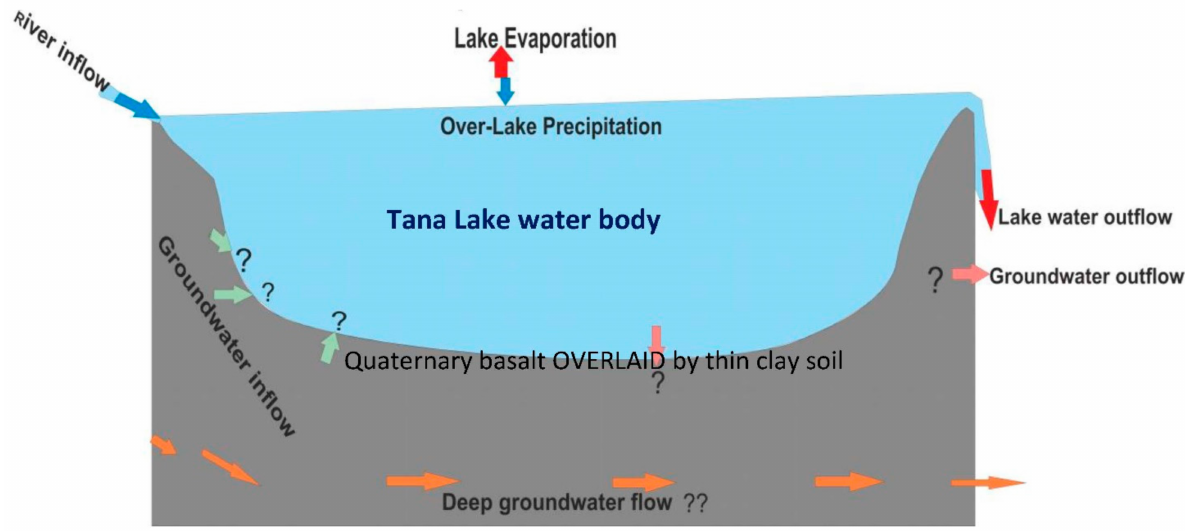
Figure 4. Conceptual diagram depicting possible water balance components at Lake Tana. Uncertainties are indicated by question